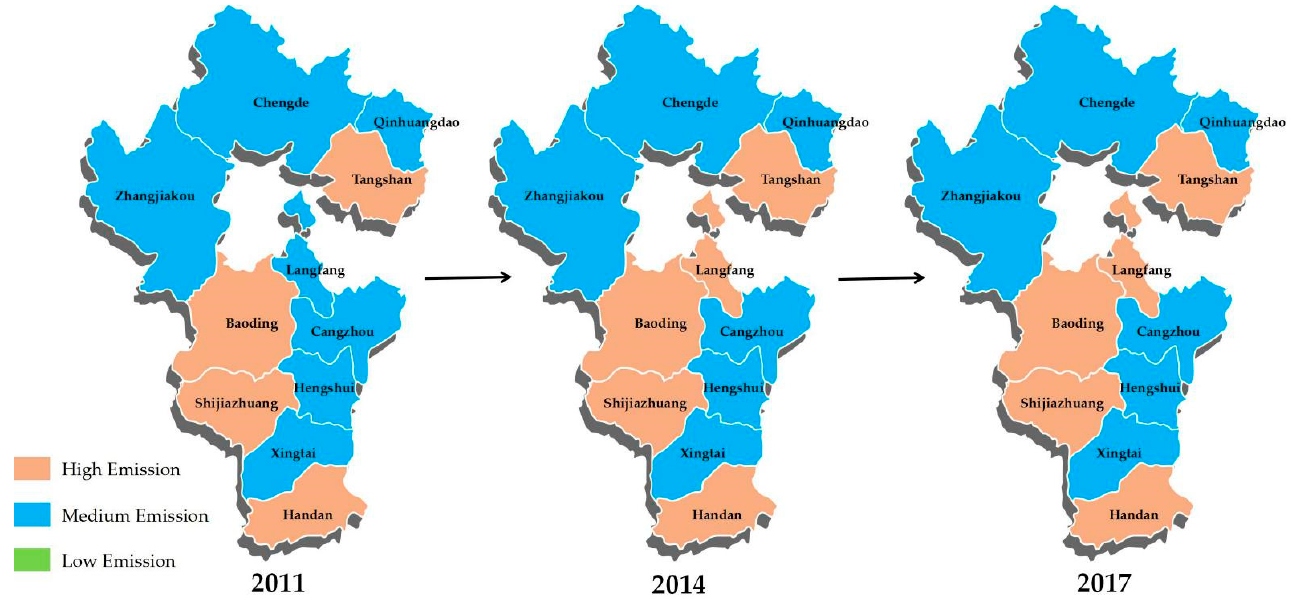
Figure 4. Spatio-temporal evolution map of carbon emissions in Hebei Province.